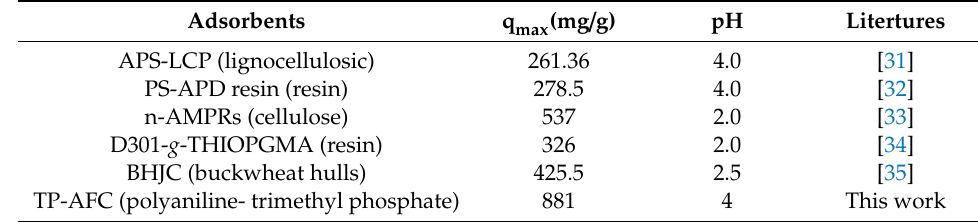
Table 5. Comparison of the adsorption capacity for gold ion.